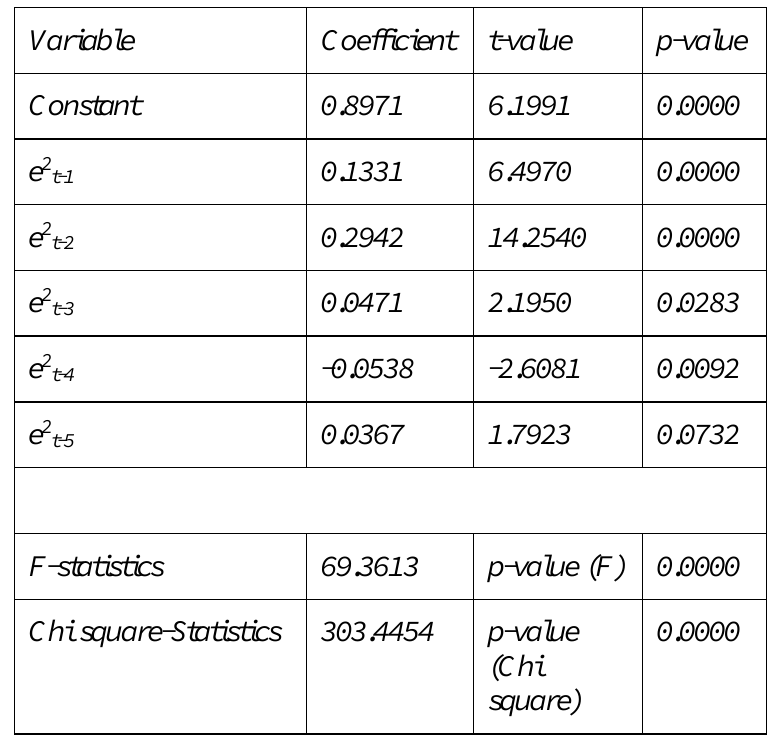
Table 2: LM test